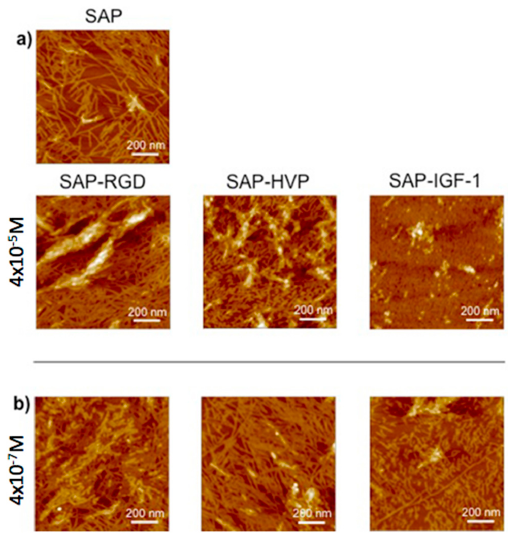
Figure 3. Atomic Force Microscopy (AFM) images of: ( a ) Self-assembling peptide hydrogel pristine (SAP) or enriched with conjugates between SAPs and adhesive peptides (called SAP-RGD and SAP-HVP) or decorated with a conjugate between SAP and Insulin-like Growth factor-1 (called SAP-IGF-1) at 4 × 10 − 5 M; and ( b ) SAP-RGD, SAP-HVP and SAP-IGF-1 at 4 × 10 − 7 M on mica surface.